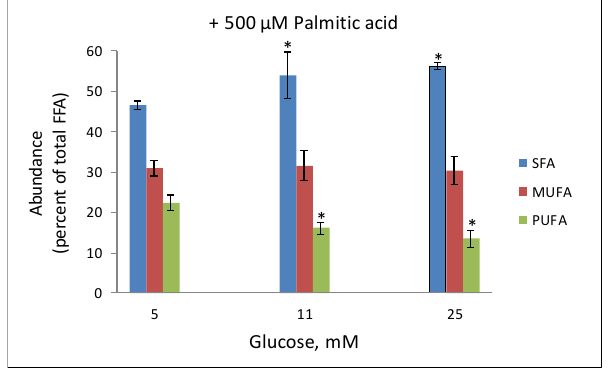
Figure 2. Impact of palmitic acid on fatty acid abundance in phospholipids of INS-1E cells. INS-1E cells were incubated in serum-free medium supplemented with the indicated glucose concentration for 32 h. Palmitic acid (500 µM) was added during the last 16 h of incubation. The cells were then harvested and processed for lipidomics analysis as described [11]. The abundance of SFA, MUFA and PUFA is given as percent of total fatty acid content. Mean ± SEM, n = 4. * p < 0.05 significantly different from the corresponding values at the 5 mM glucose incubation (adapted from [11]).